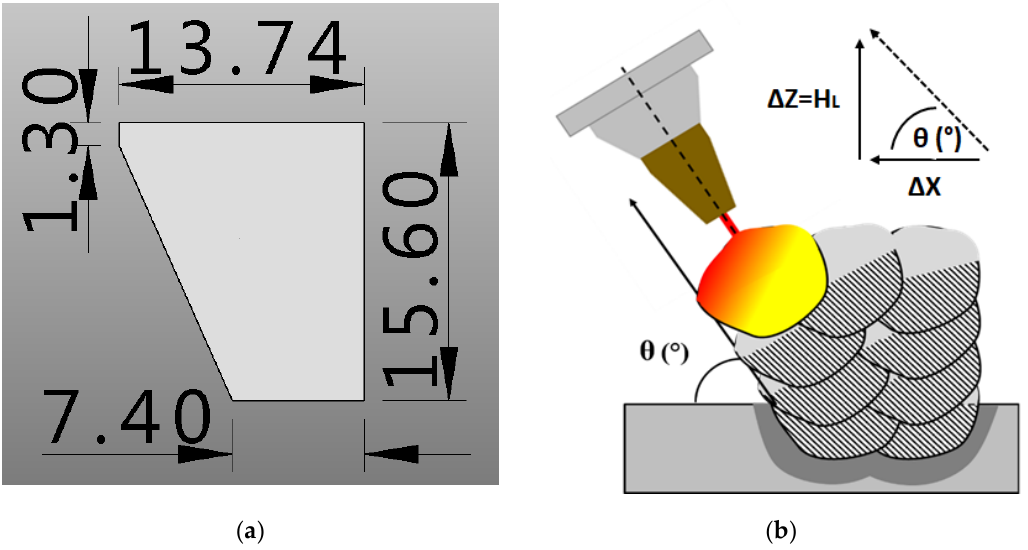
Figure 10. ( a ) Cross-sectional dimensions of the target geometry employed for the development and validation of the deposition strategy for inclined walls of variable thickness; ( b ) scheme of the deposition strategy to validate. (unit: mm)